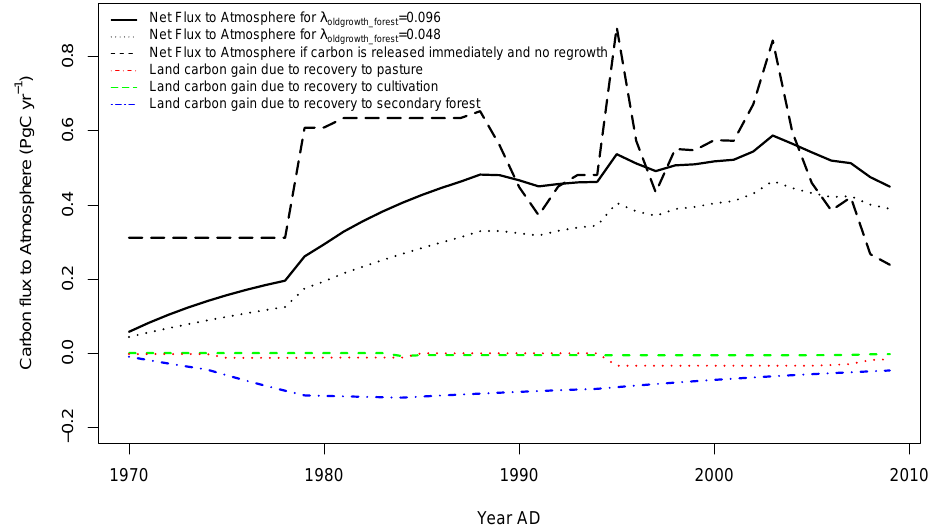
Fig. 8. Estimates of carbon released to the atmosphere from South America due to deforestation for two scenarios: (i) carbon is released gradually and regrowth is taken into account using a simplified book-keeping model following Houghton (1983) as described in Sect. 3.2 and the Appendix, and (ii) all forest carbon after deforestation is released immediately to the atmosphere and there is no